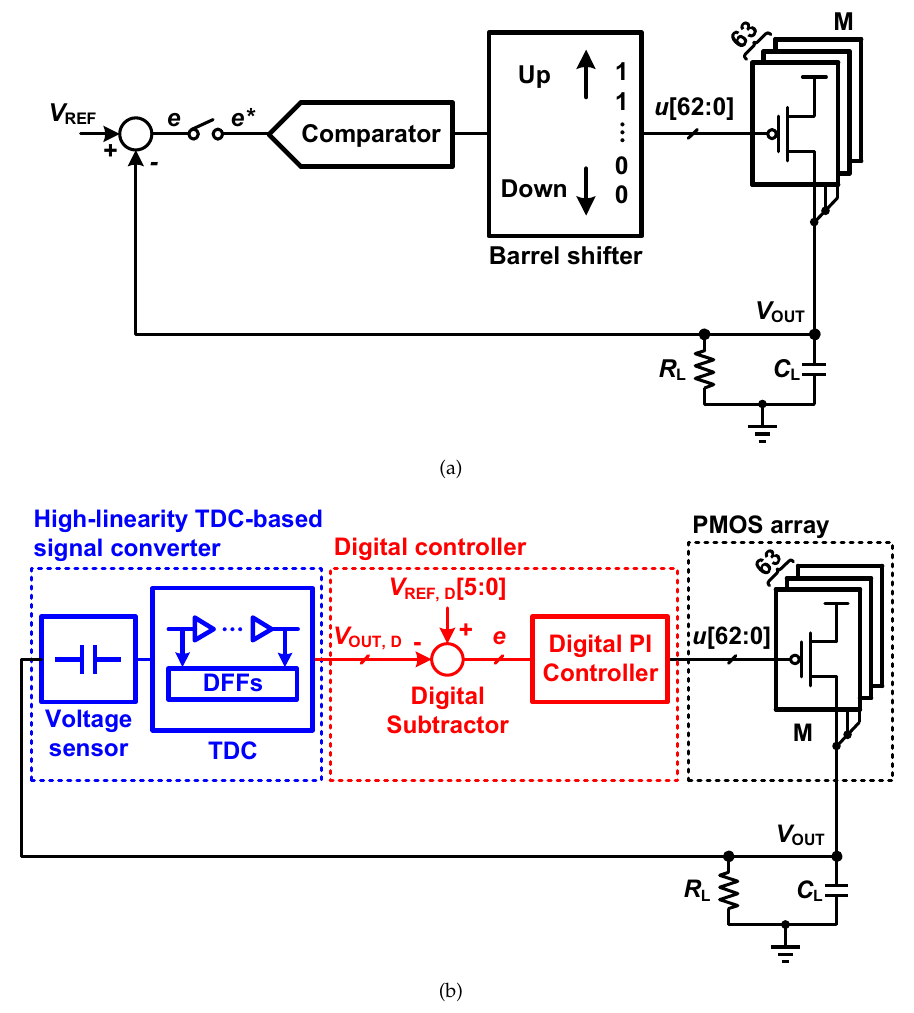
Figure 1. The circuit architecture of ( a ) baseline DLDO and ( b ) proposed